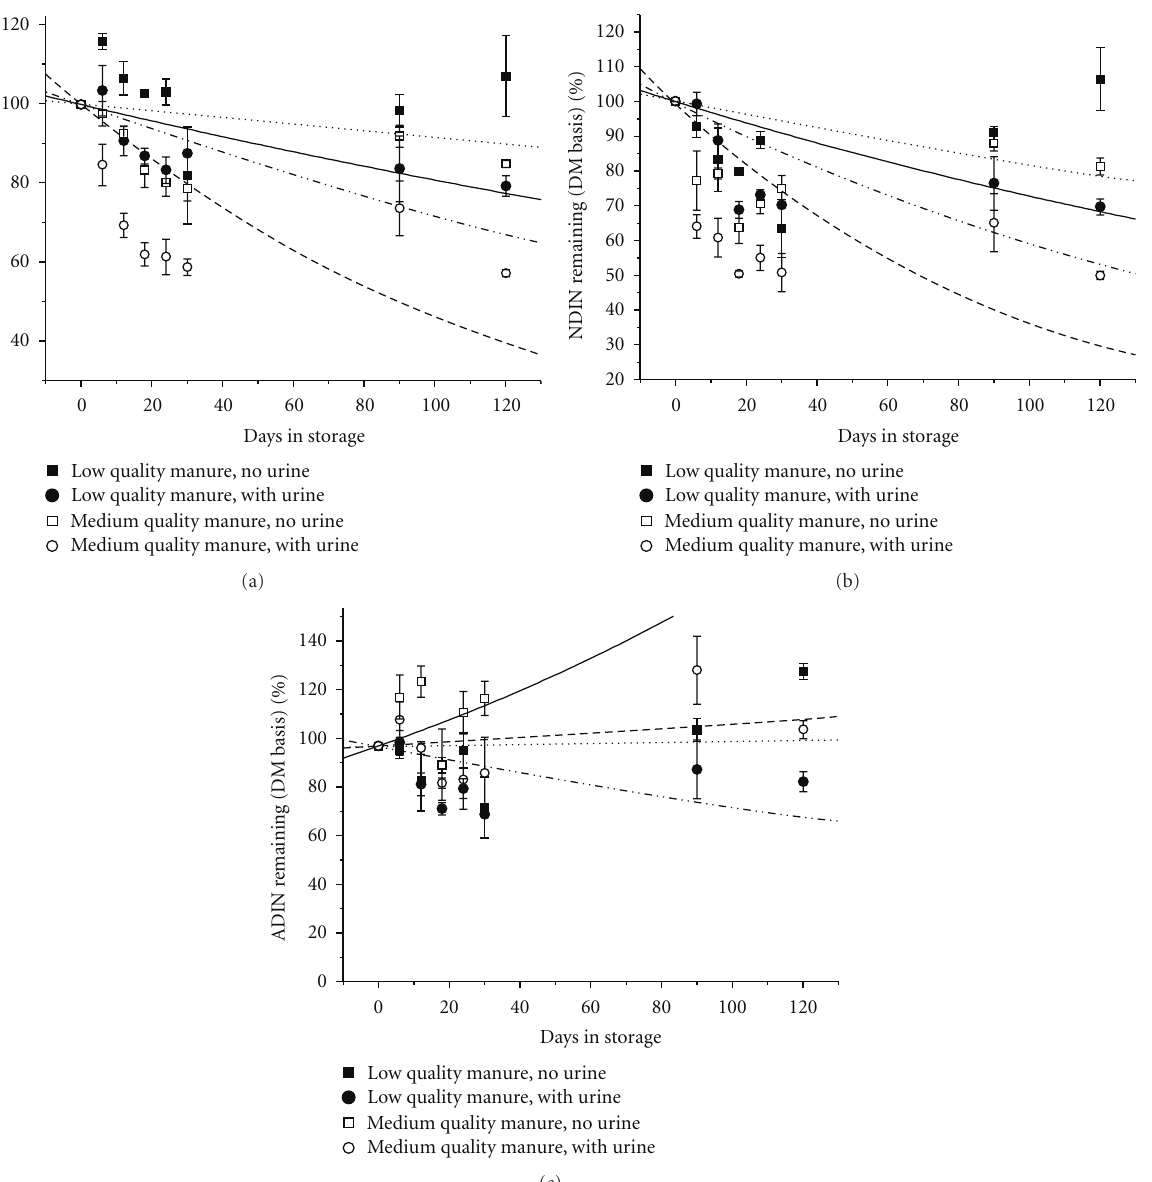
Figure 4: Total organic N, neutral detergent insoluble N (NDIN), and acid detergent insoluble N (ADIN) dynamics in manure in the dry season experiment (DM basis). Error bars represent standard error of means. Continuous lines represent best-fit regression equations for organic N dynamics in manure during the dry season experiment. Y represents the amount of organic N, NDIN, or ADIN remaining in the manure (% of initial content, DM basis). The solid line (—) represents the Medium quality manure, no urine treatment. The dashed line (----) represents the urine-amended Medium quality manure treatment. The dotted line ( ···· ) represents the Low quality manure, no urine treatment. The dot-dash line (- ·· - ·· ) represents the urine-amended Low quality manure treatment. (a) Total organic N dynamics (% N, DM basis). Medium quality manure, no urine: Y = 100 e − 0 . 00213 x , R 2 = 0 . 978. Medium quality manure, with urine: Y = 100 e − 0 . 00768 x , R 2 = 0 . 916. Low quality manure, no urine: Y = 100 e − 0 . 00087 x , R 2 = 0 . 971. Low quality manure, with urine: Y = 100 e − 0 . 00327 x , R 2 = 0 . 982. The rate equations for NDIN dynamics between the four treatments did not di ff er at significance level α = 0.05. (b) NDIN dynamics (%NDIN, DM basis). Medium quality manure, no urine: Y = 100 e − 0 . 00318 x , R 2 = 0 . 940. Medium quality manure, with urine: Y = 100 e − 0 . 00994 x , R 2 = 0 . 823.